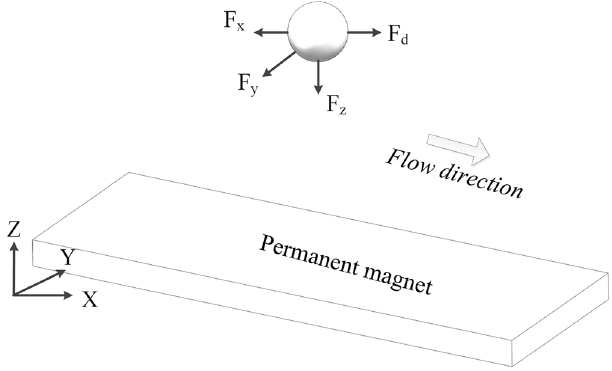
Figure 9. Forces of magnetic